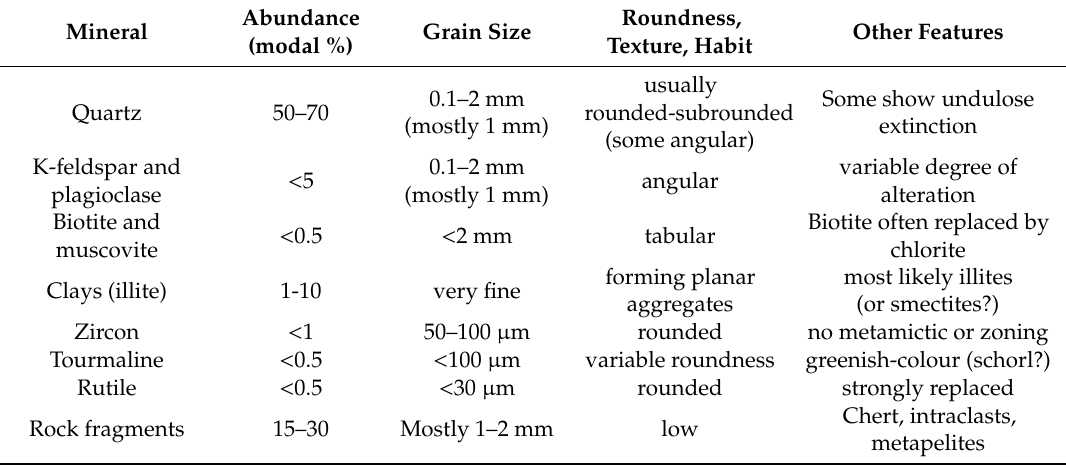
Table 1. Composition of detrital particles in the sandstones of the Eureka deposit.